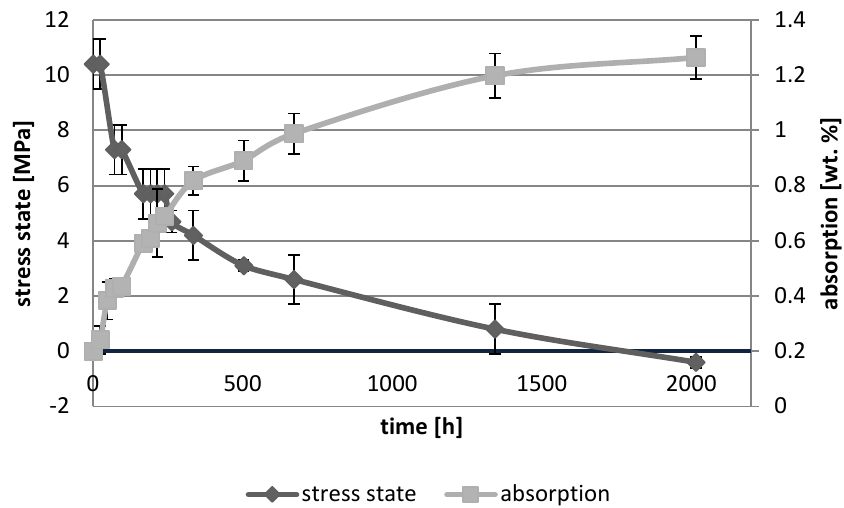
Figure 5. The relationship of absorption and stress state during water ageing (2016 h) of